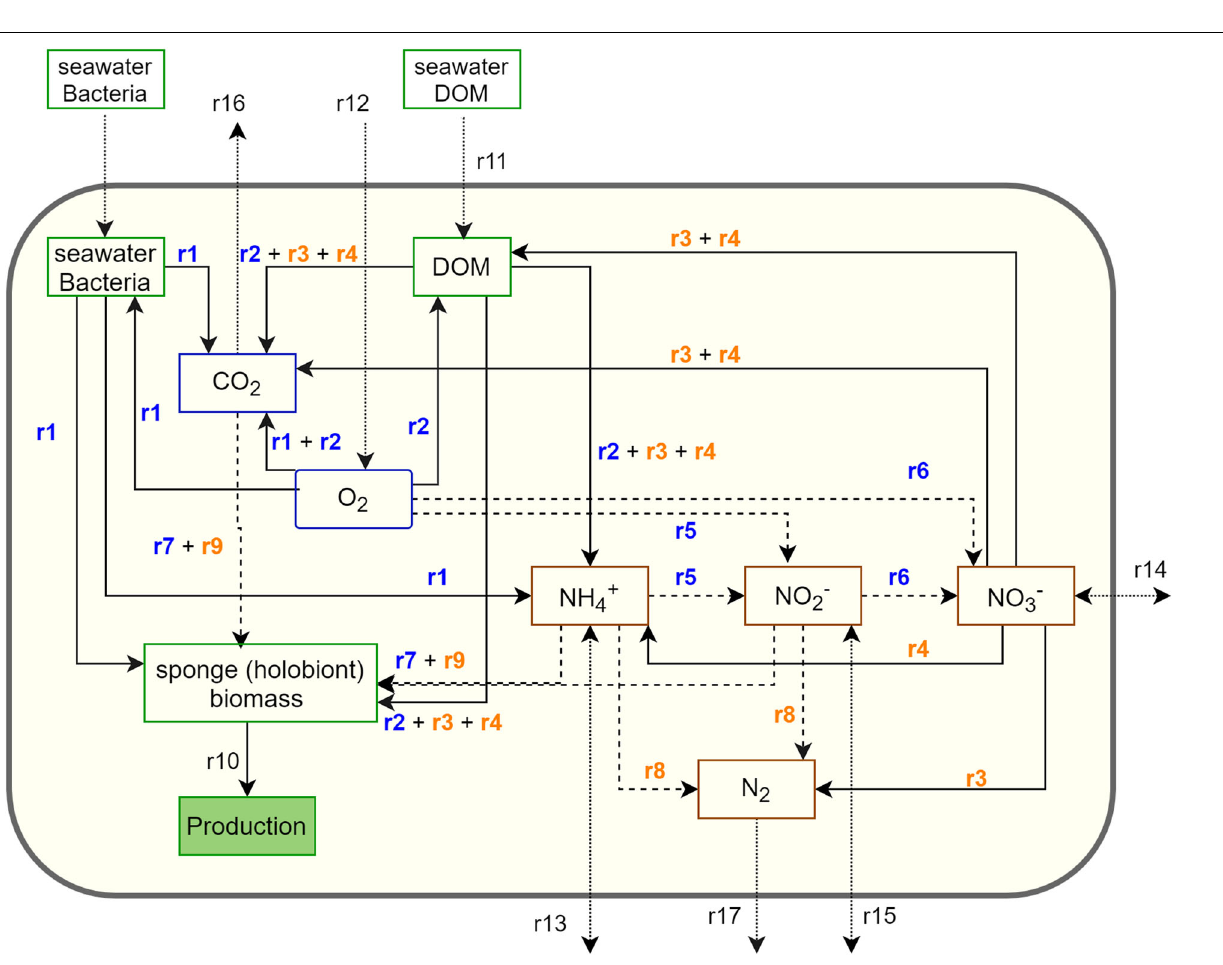
FIGURE 1 | Schematic representation of the metabolic network model for a sponge holobiont (large yellow box) containing nitrogen species (brown boxes), organic substances (green boxes), and O 2 /CO 2 (blue boxes). Production (filled green) is not a standing stock, but a closure term for production of sponge biomass. The arrows indicate metabolic transformations: solid arrows refer to heterotrophic processes, dashed arrows refer to chemoautotrophy, and dotted arrows indicate exchange with the environment. Reaction numbers correspond with those in Table 2 : blue numbers indicate aerobic processes, and orange numbers indicate anaerobic